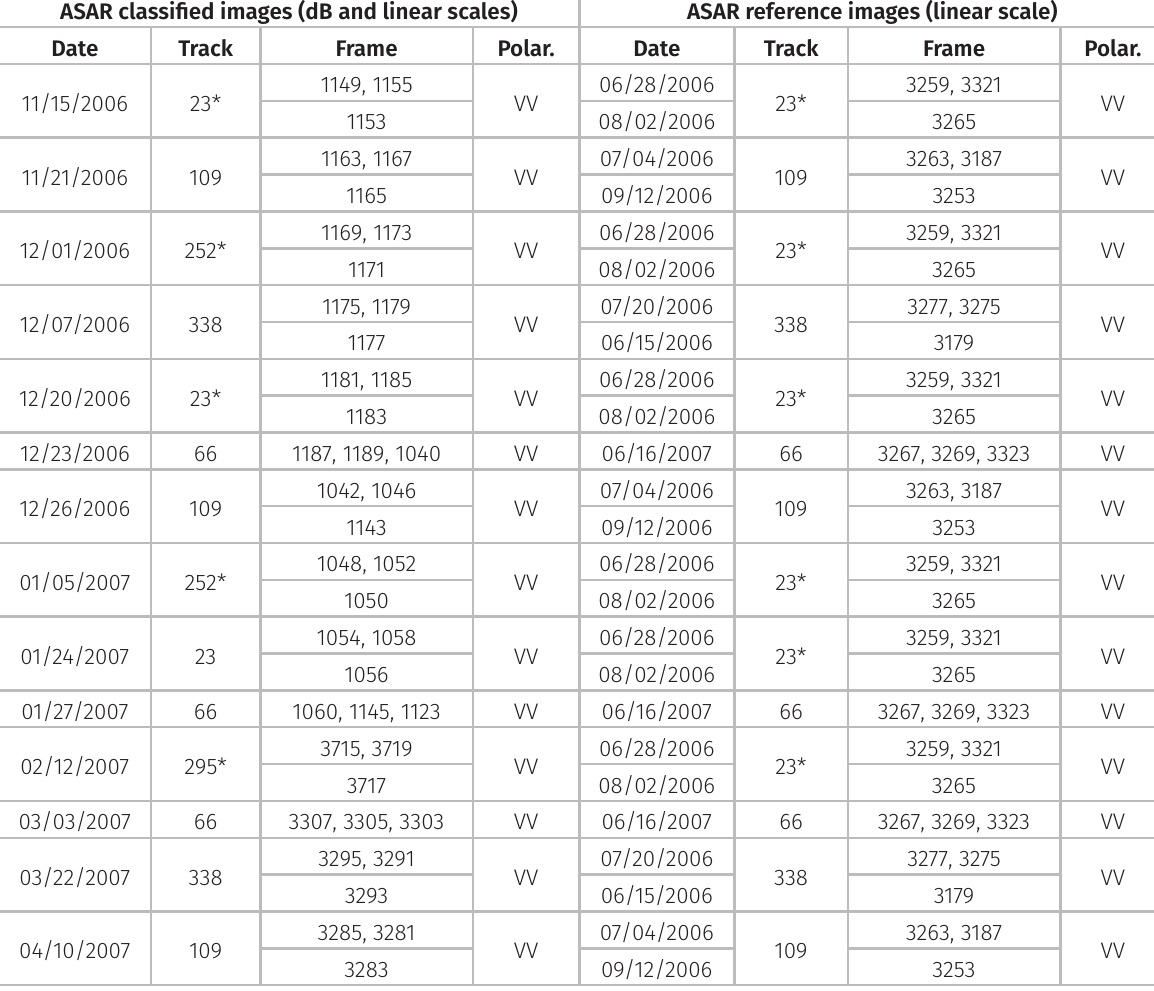
Table I. Date of acquisition and track/frame of ASAR images on wide swath mode (VV polarized) used in the classification of the Wet Snow Zone in the Antarctic Peninsula. ASAR classified images (dB and linear